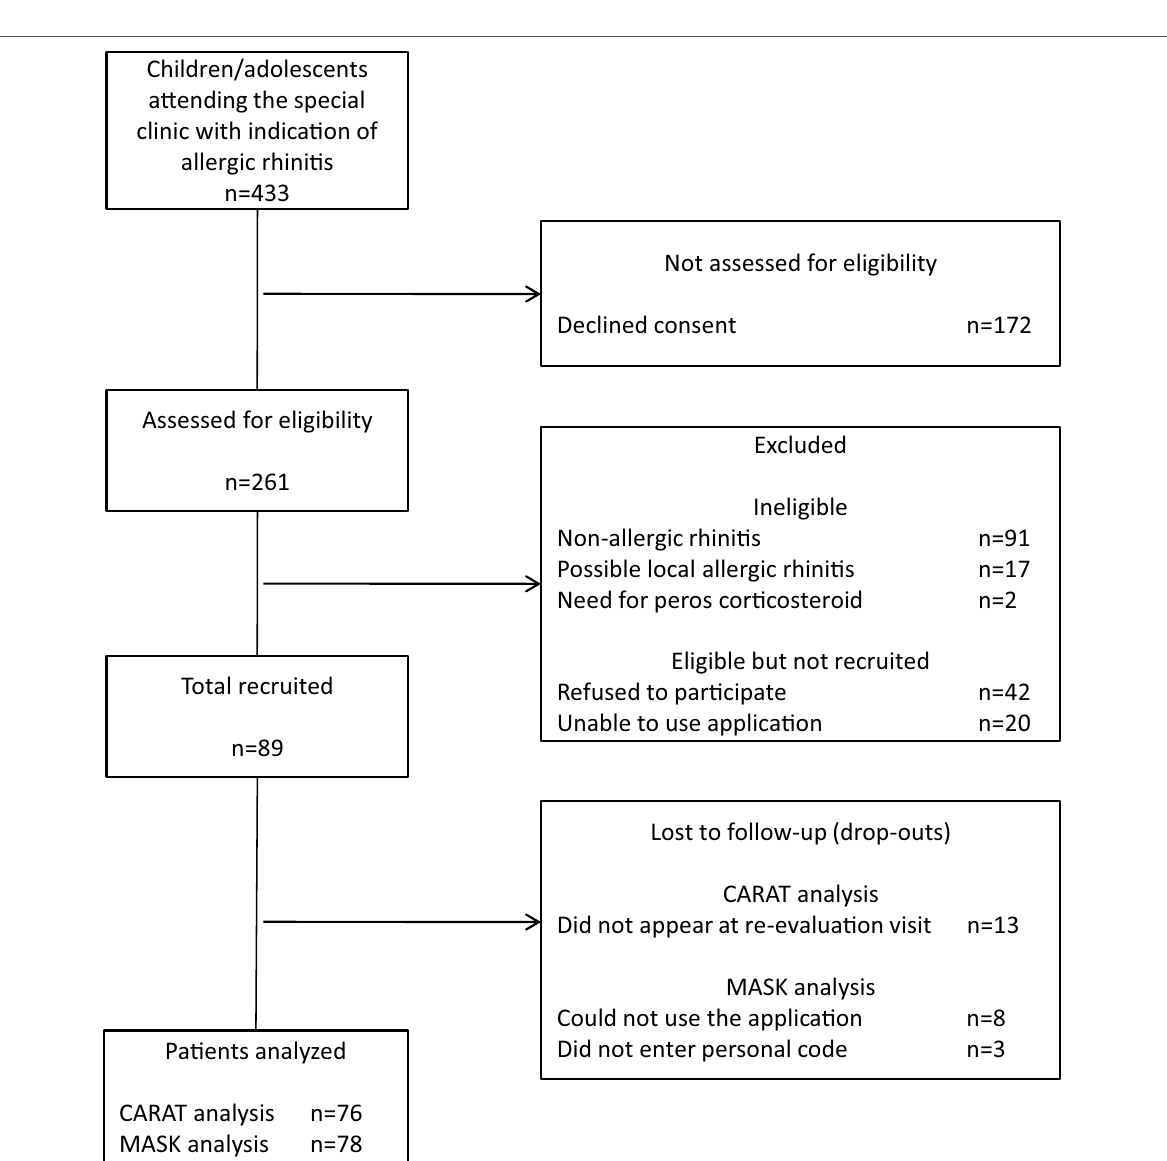
(Fig. 2a). Moreover, the improvement of CARAT10 score (i.e. the individual differences between day 1 and day 30) was significantly higher for the active than for the control group (median increase: 5.0 vs. 1.0, respec- tively; p 0.023) (Table 2). This difference surpassed = the limit of 3.5 that is considered by the CARAT devel- opers (also co-authors of the present study) to be the minimal clinically relevant difference [20] and was achieved despite the fact that both groups had (i) simi- lar instructions in regard to regular pharmaceutical